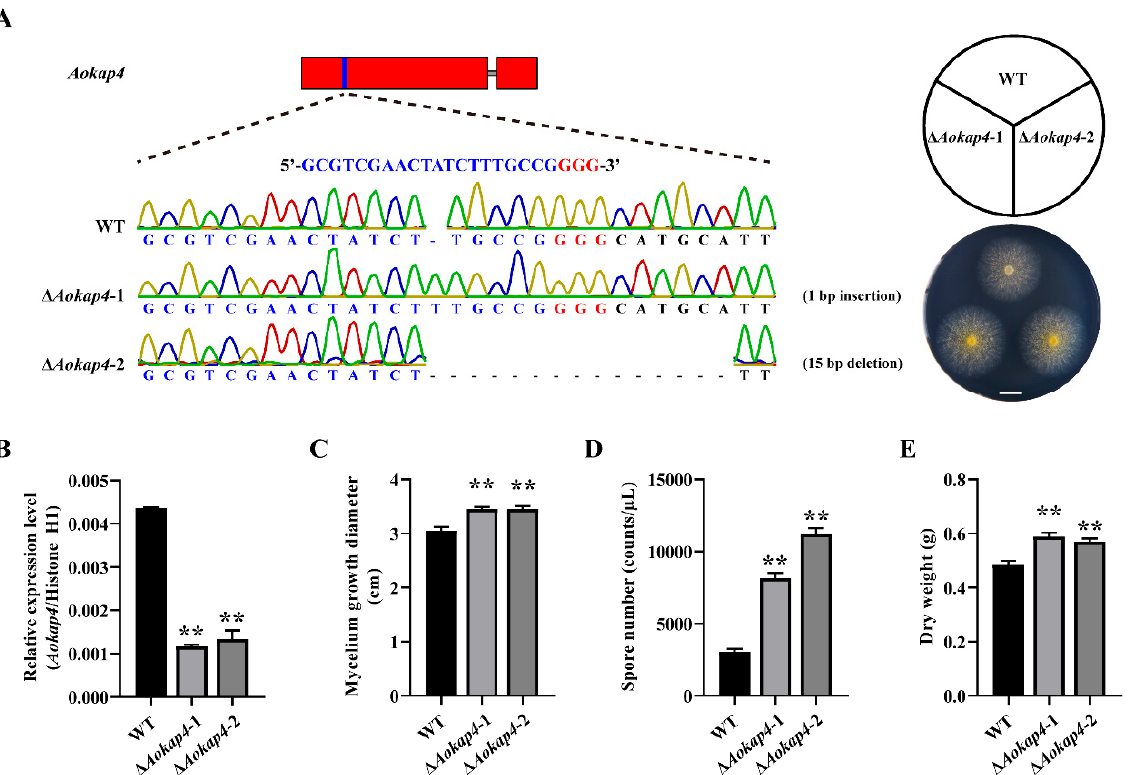
Figure 2. Effects of disruption of Aokap4 on the growth of A. oryzae . ( A ) Construction of Aokap4- deletion mutants using the CRISPR/Cas9 system. The targeted sequence for Aokap4 is shown in blue and the corresponding PAM sequence is indicated in red. The number and types of mutations are shown on the right. The Aokap4- deletion mutants ∆ Aokap4 -1 and ∆ Aokap4 -2 harbor a 1 bp insertion and a 15 bp deletion generated by CRISPR/Cas9, respectively. The wild-type (WT), Δ Aokap4 -1 and ∆ Aokap4 -2 were grown on the Czapek-Dox (CD) agar medium for three days. ( B ) Transcript levels of Aokap4 in the WT and Aokap4- deletion strains. The mycelia from these fungal strains, cultivated in the modified CD liquid medium for four days at 30 °C, were collected to isolate total RNA. The relative expression levels of the Aokap4 gene were examined via qPCR based on three replicates. ( C – E ) Comparison of colony diameter ( C ), conidia formation ( D ) and biomass ( E ) in the WT and Aokap4- deletion strains. Asterisks indicate statistical significance in the differences between the WT and Aokap4- deletion strains based on Student’s t -tests (** p < 0.01). Scale bars = 1 cm.